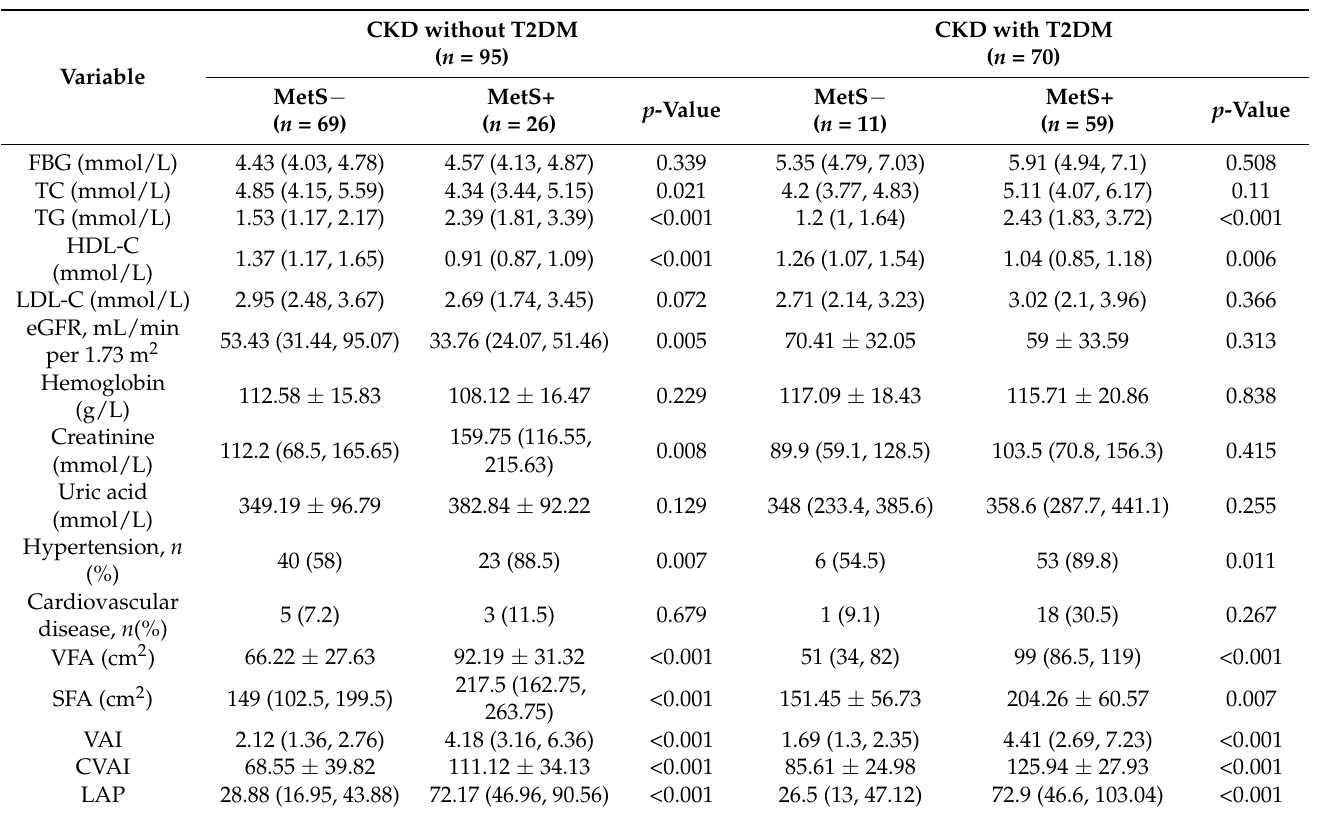
Table S1). After adjusting for age, systolic blood pressure, total cholesterol, LDL cholesterol and eGFR, using the IDF criteria, WC had the highest, with OR of 2.733 (95% CI 1.797–4.156) in men with CKD and T2DM, but in women with CKD and T2DM, while the OR values of BMI were the largest, at 2.999 (95% CI 1.653–5.441). The OR values of BMI were the largest in men and women with CKD without T2DM, being 2.146 (95% CI 1.672–2.756) and 1.619 (95% CI 1.317–1.990), respectively (Supplementary Table